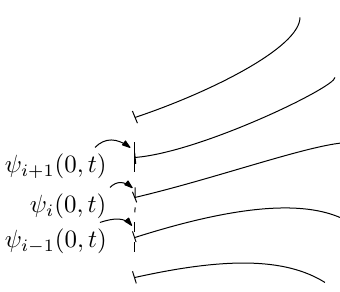
Figure 3. Schematics of the concept of basal coupling among contiguous